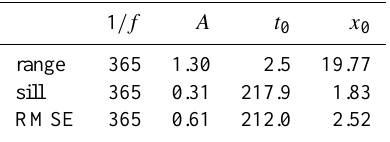
Table 2. Parameters of the sqrt-sqrt transformed cosine functions of the sill, range and root mean square errors for the fitted spherical variograms using the daily rain sums of 33 KNMI stations with a 90-day moving average